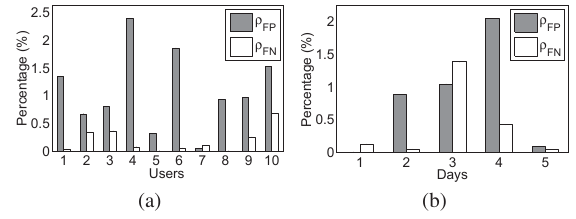
Figure 8: (a, b) ROC curves and (c) ρ FP Vs. ρ FN values for a randomly selected user for all algorithms in dataset ‘D1’. ATiS achieves very high true positive and true negative values and very low ρ FP and ρ FN values simultaneously. Table 3: Fine-grained measurements for Wi-Fi